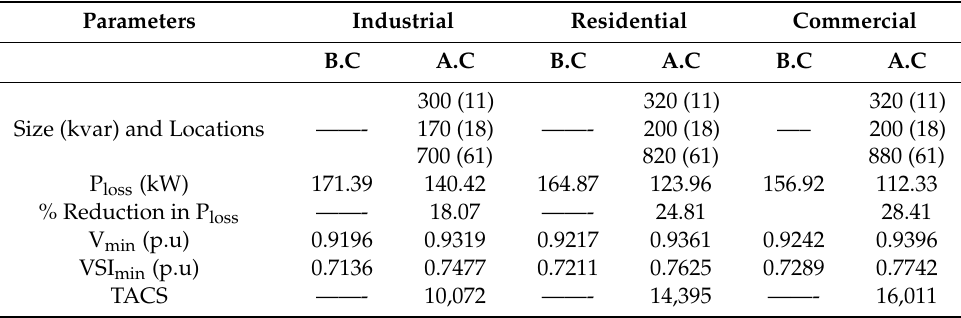
Table 6. Results of standard 69-bus system with di ff erent Load Models.